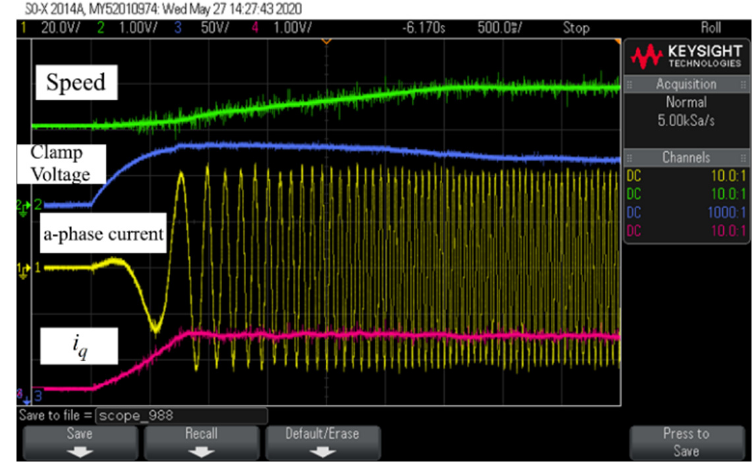
Figure 19. The measured responses using a silicon-carbide matrix-converter with a 50 kHz switching frequency.